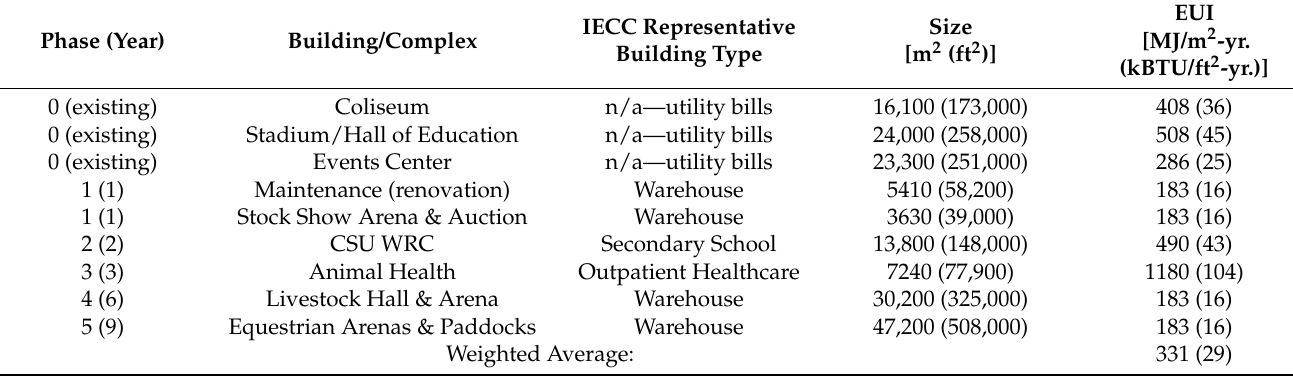
Table A3. NWC Energy Use Intensity (EUI) Summary (normal load profile) for the various building complexes, including the phase and year for which their energy load and generation comes on-line in the 30-year energy and economic analysis. The healthcare and secondary school EUI are considerably higher than existing buildings, while the warehouse is much lower than the historical buildings, reflective of advances in building construction energy